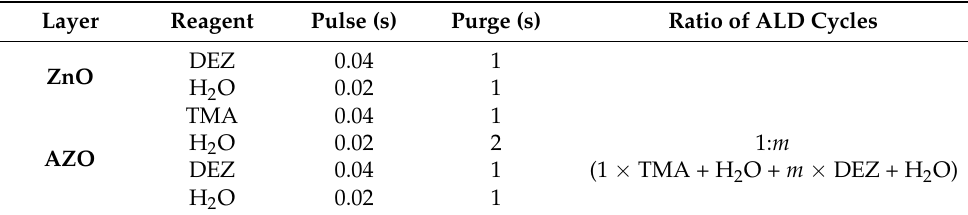
Table 1. The ALD growth parameters of ZnO and AZO layers.